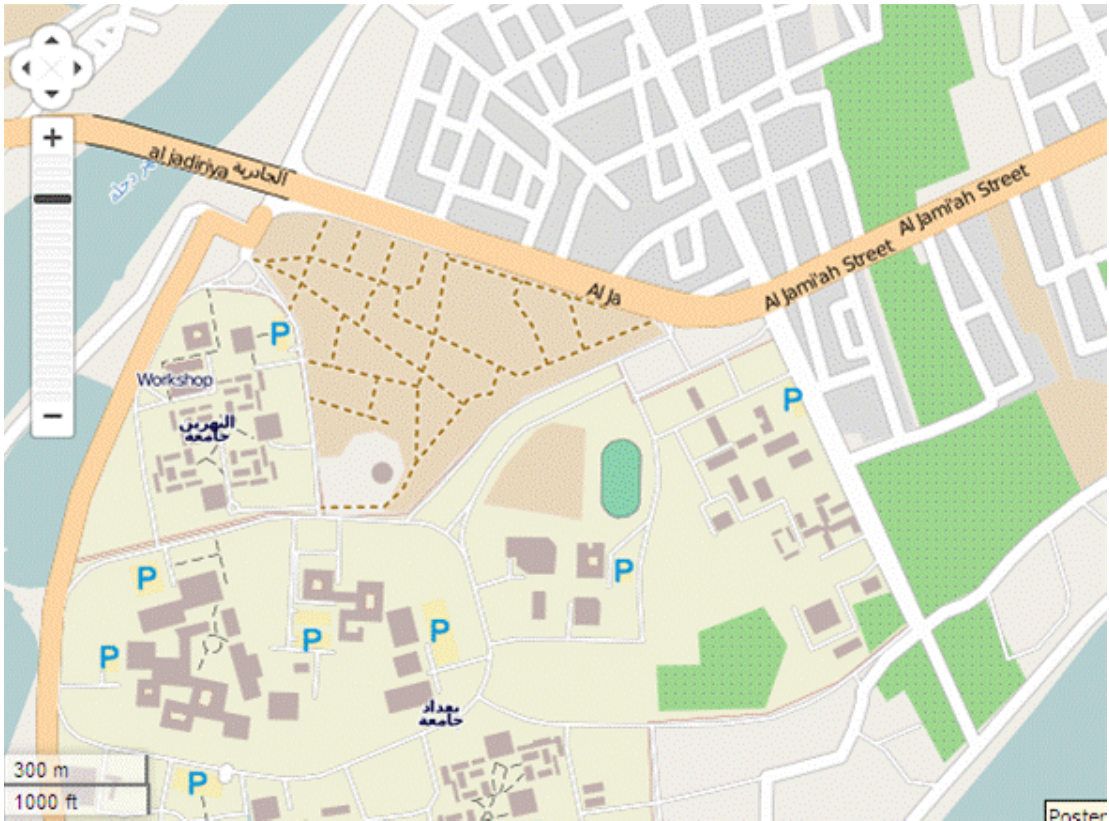
Figure 3. OpenStreetMap representation of the study area at